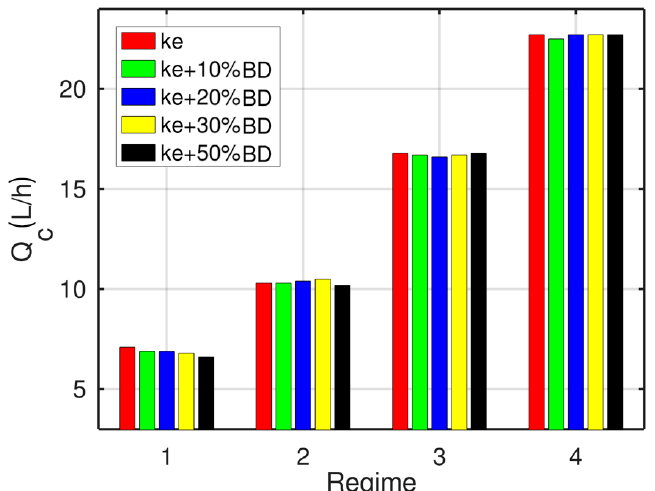
Figure 10. Variation of Qc (L/h) depending on the regime and blend.